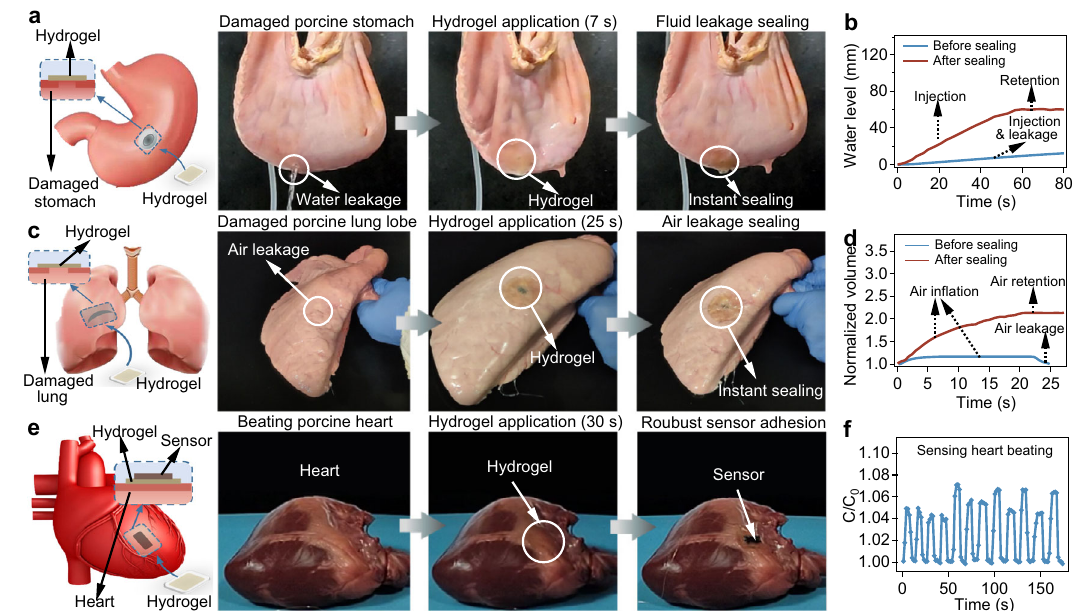
Fig. 4 Applications of the Electro-Ox hydrogel tape to tissue adhesion. a Sealing of a water-leaking porcine stomach using Electro-Ox hydrogel tape. b Water level in the stomach corresponding to the sealing process in a . c Sealing of an air-leaking porcine lung using Electro-Ox dopa hydrogel tape. d Volume change in the lung corresponding to the sealing process in c . e Electro-Ox hydrogel tape-mediated adhesion of a hydrogel-based strain sensor on a beating porcine heart driven by an air pump. f Normalized capacitance ( C / C 0 ) of the strain sensor adhered to the porcine heart over time corresponding to mimicked heart beating in e